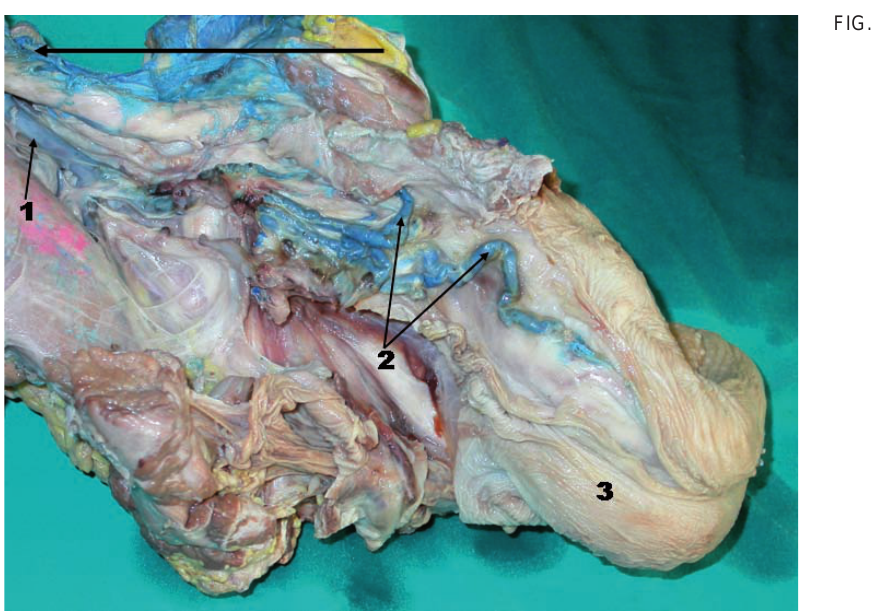
FIG. 9 Ventro-lateral view of the phal- lus showing the V. pudenda dextra (1) receiving large, su- perficial tributaries (2) from the root and body of the phallus (3). Arrow top left indicates caudo-cranial direction. Latex